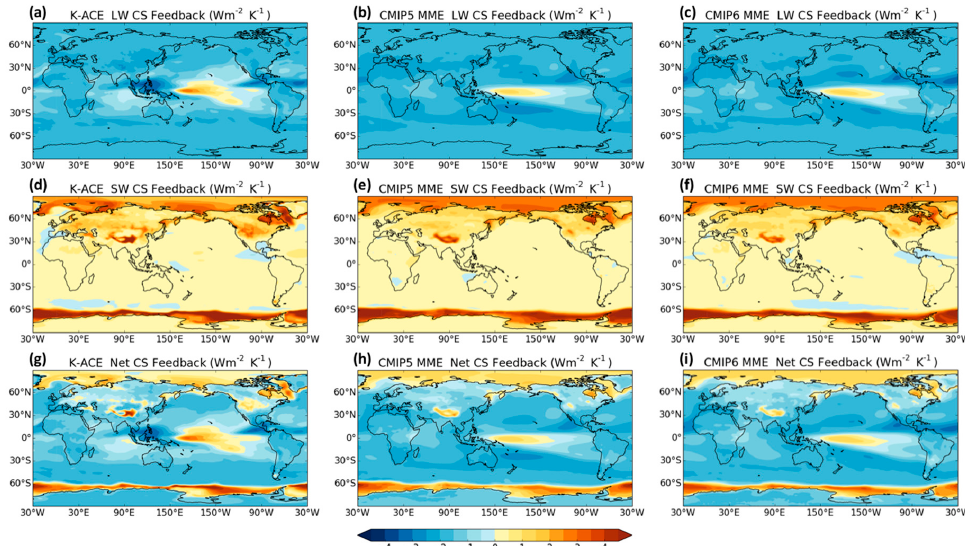
Figure 5. Global distribution of the longwave (LW; first row), shortwave (SW; second row), and net (third row) clear-sky feedback components in Wm − 2 K − 1 for the K-ACE ( a , d , g ), CMIP5 ( b , e , h ), and CMIP6 ( c , f , i ) models. These patterns are determined from the slope of the linear regression of the change in local radiative flux against global mean air temperature change over the 150 years in the abrupt experiment.